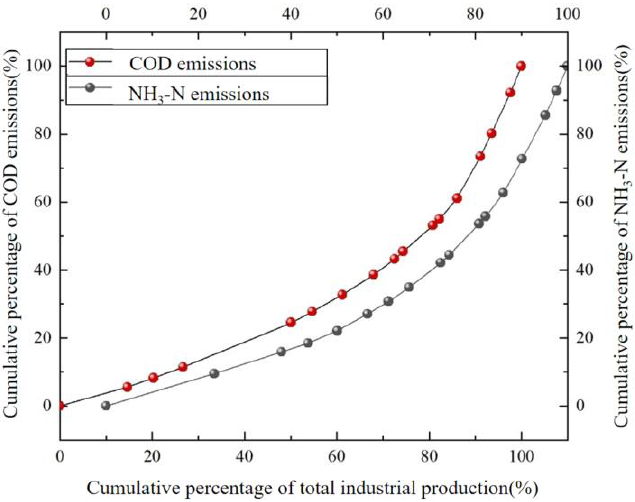
Figure 5. Lorenz curves of COD and NH 3 -N based on total water resources indicators.